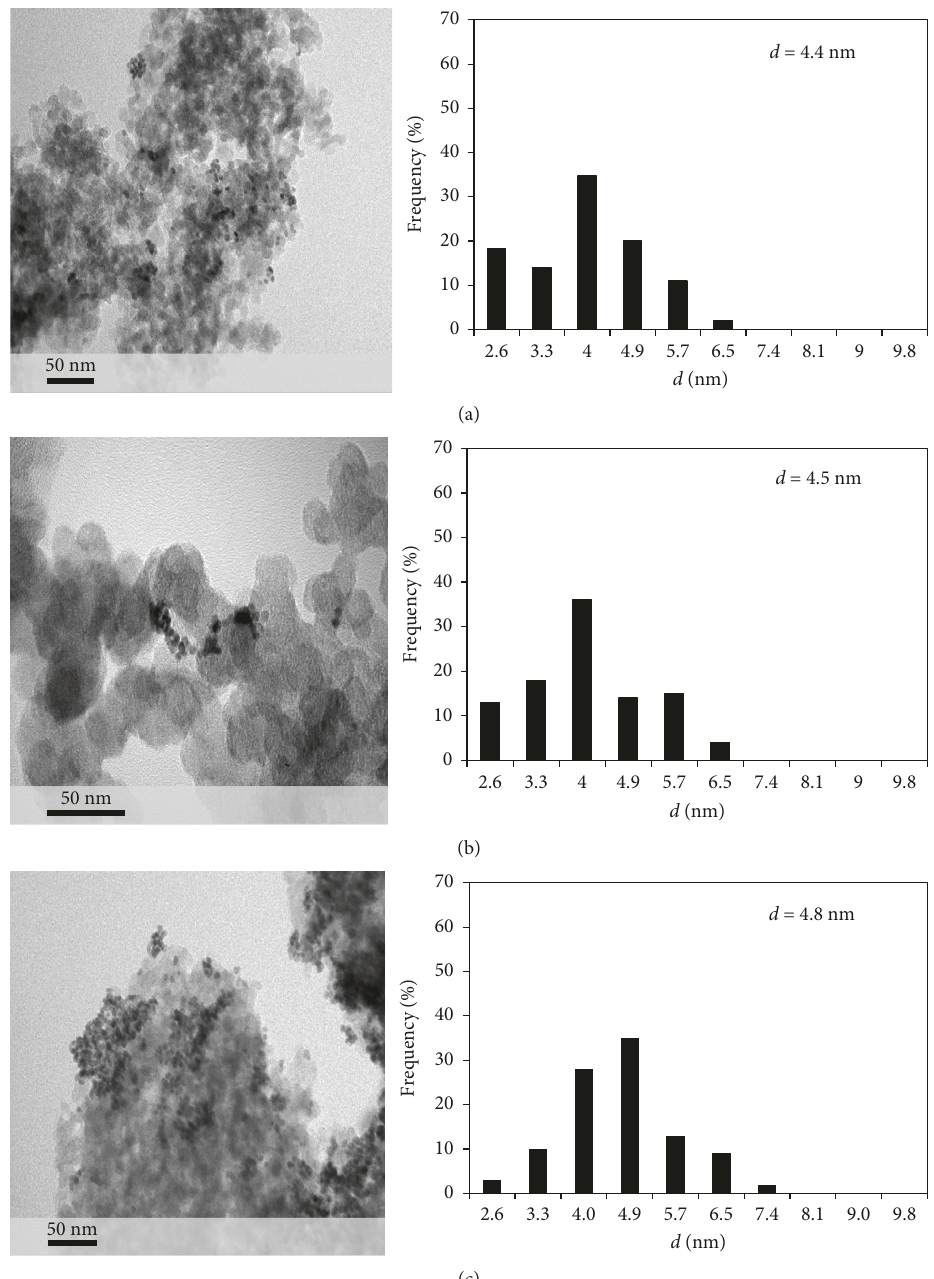
Figure 4: TEM micrographs of bimetallic (a) PdIr-0.02/C, (b) PdIr-0.08/C, and (c) PdIr-0.2/C catalysts with the corresponding particle-size distribution diagrams. Table 2: XPS data and surface fraction of Pd and Ir components determined by CV measurements.